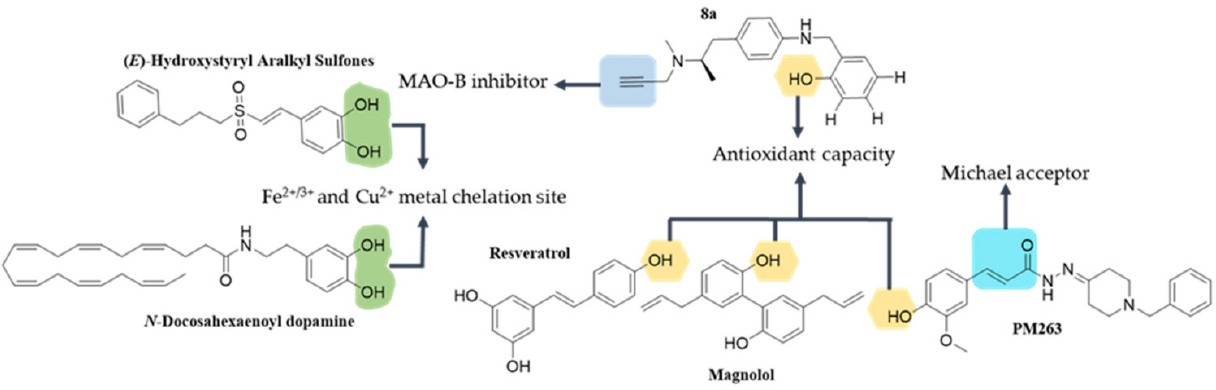
Figure 2. Structure-function association of multifunctional phenolic derivatives. Green shadow- ing shows iron chelation sites; yellow shadowing shows free radical scavenger sites.